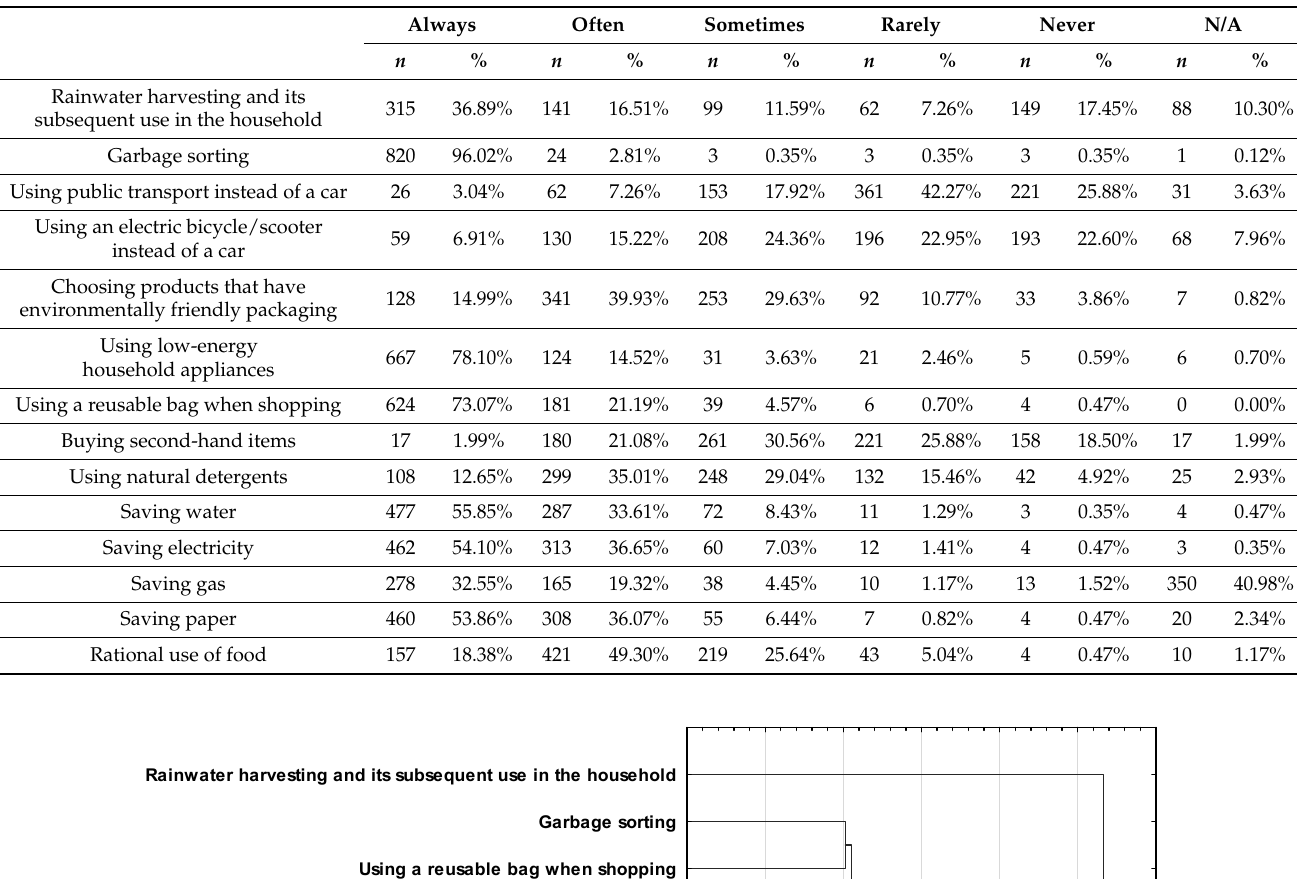
Table 4. Pro-ecological behavior taken up by respondents.